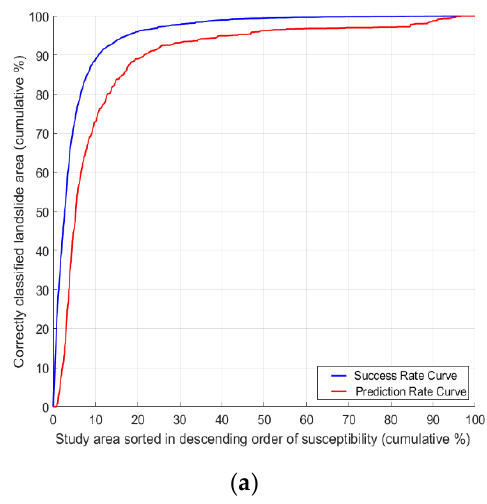
Figure 10. Success and Prediction Rate Curves for the best landslide susceptibility models, developed for: ( a ) falls and ( b ) slides.